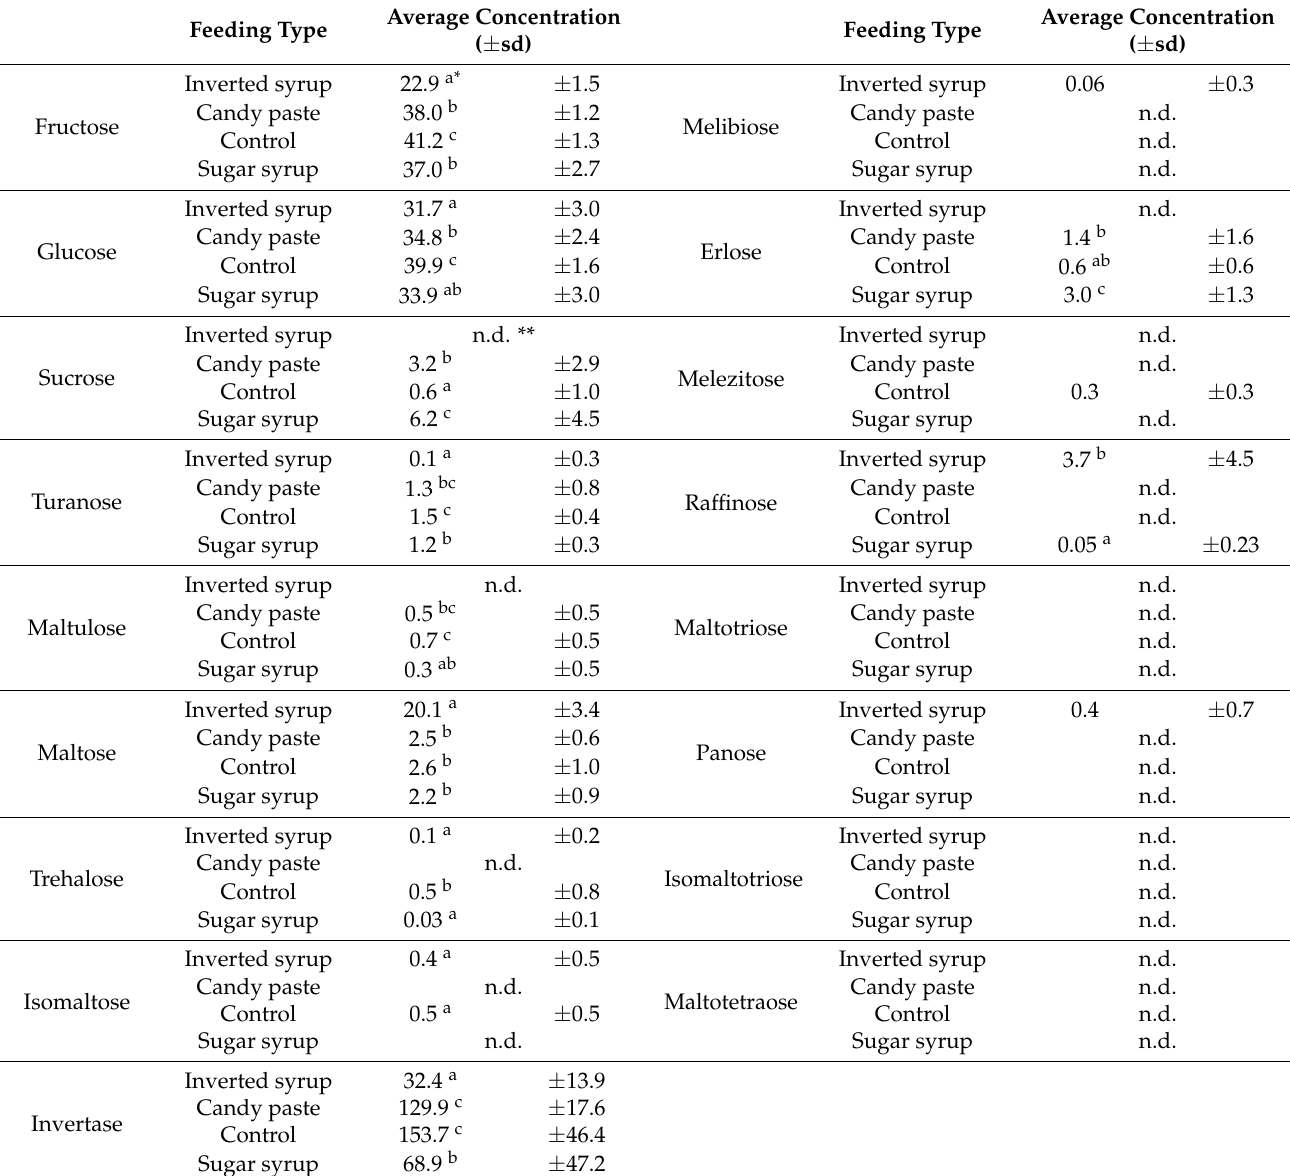
Table 3. Average ( ± sd) concentration of sugars (%) and invertase activity (U kg − 1 ) in different honey samples produced after the application of different feeding